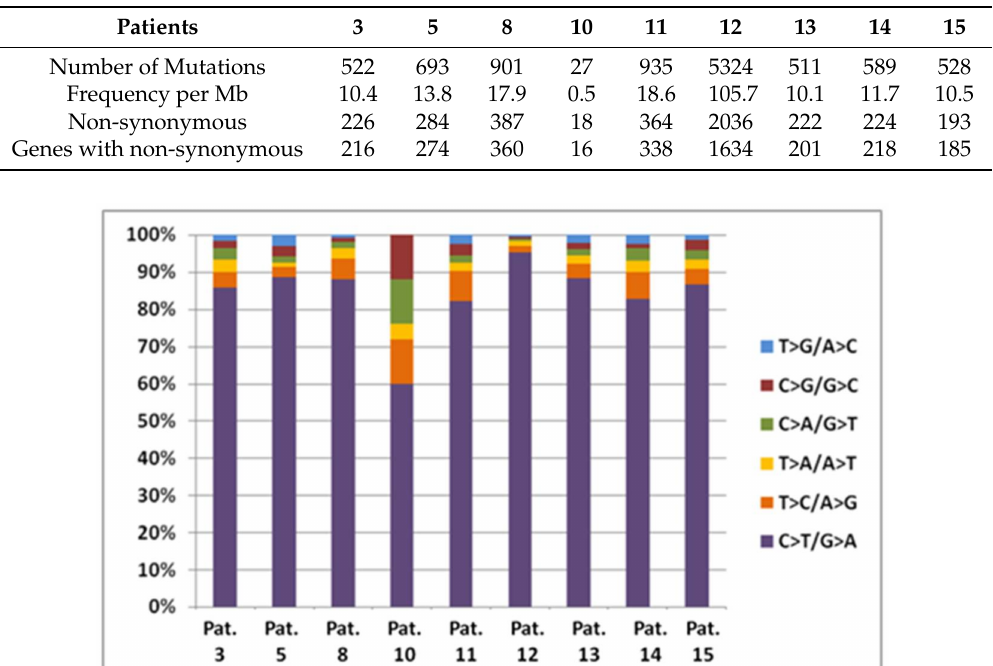
Table 3. Somatic mutation characteristics for each patient.